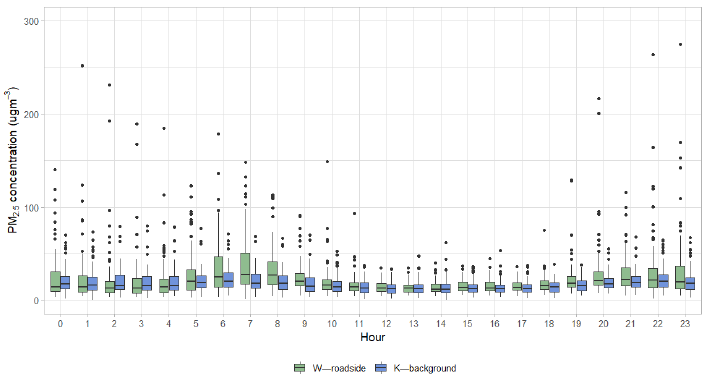
Figure 7. PM 2.5 hourly variability from 10 March to 30 May 2020.